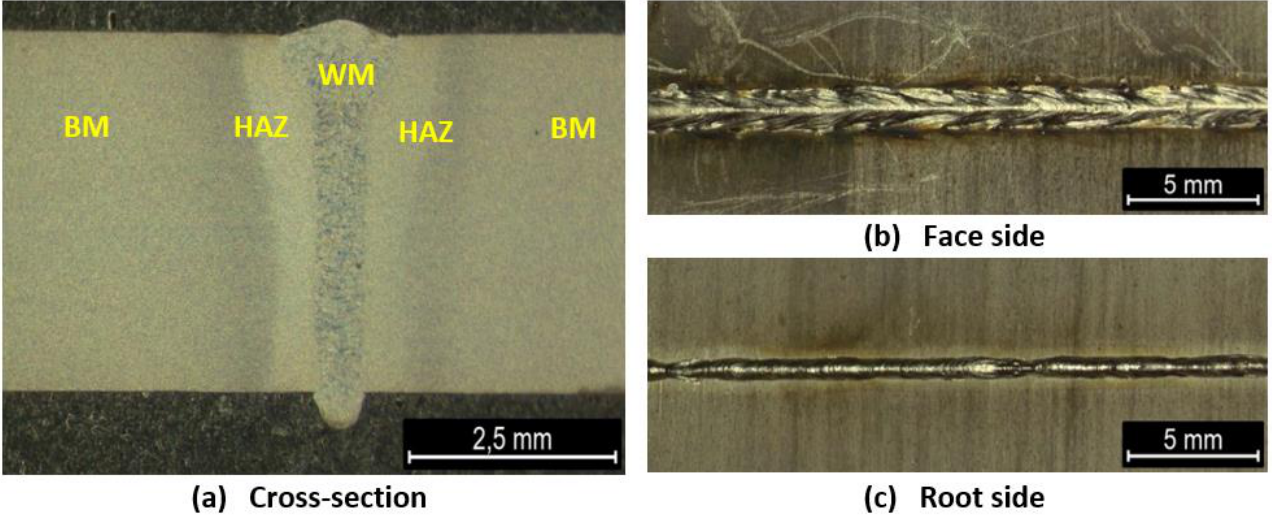
Figure 2. The macrostructure of the joints in the cross-section ( a ) and on the face ( b ) and root ( c ) side; WM — weld metal, HAZ — heat affected zone, BM — base metal.